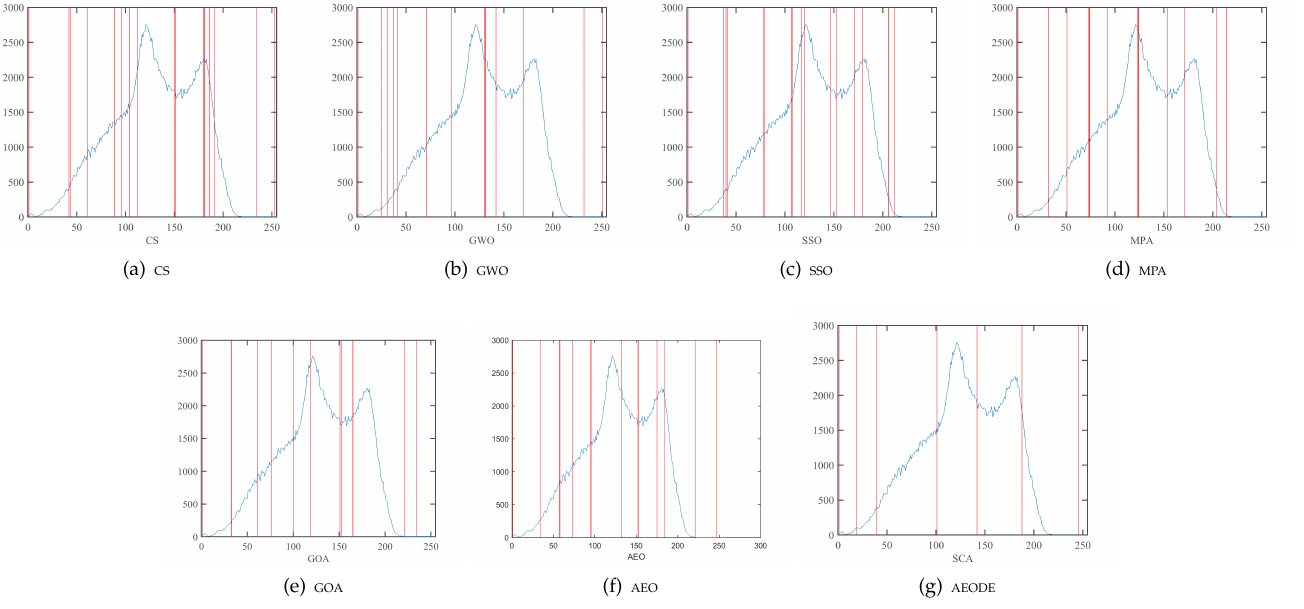
Figure 14. The threshold values at level 19 over the histogram of image